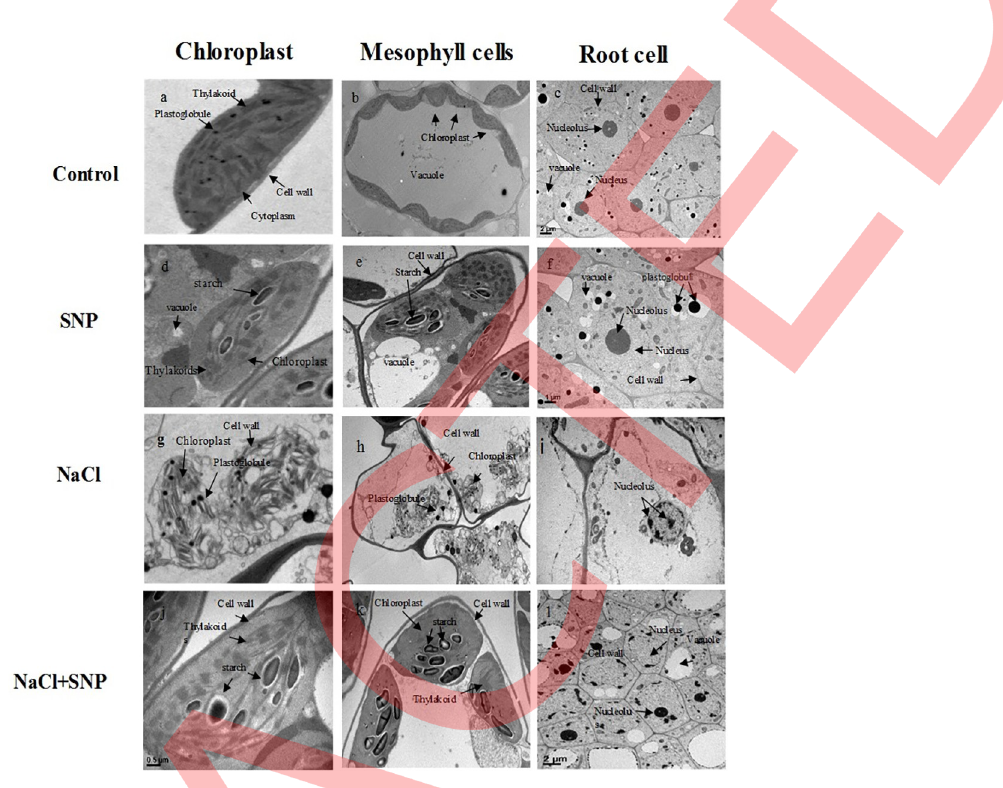
Fig 5. Transmission electron micrographs of chloroplast (a, d, g, j), mesophyll cells (b, e, h, k) and root (c, f, i, l) of control and treated plants. Bar = 0.5 μ m, 1 μ m and 2 μ m.